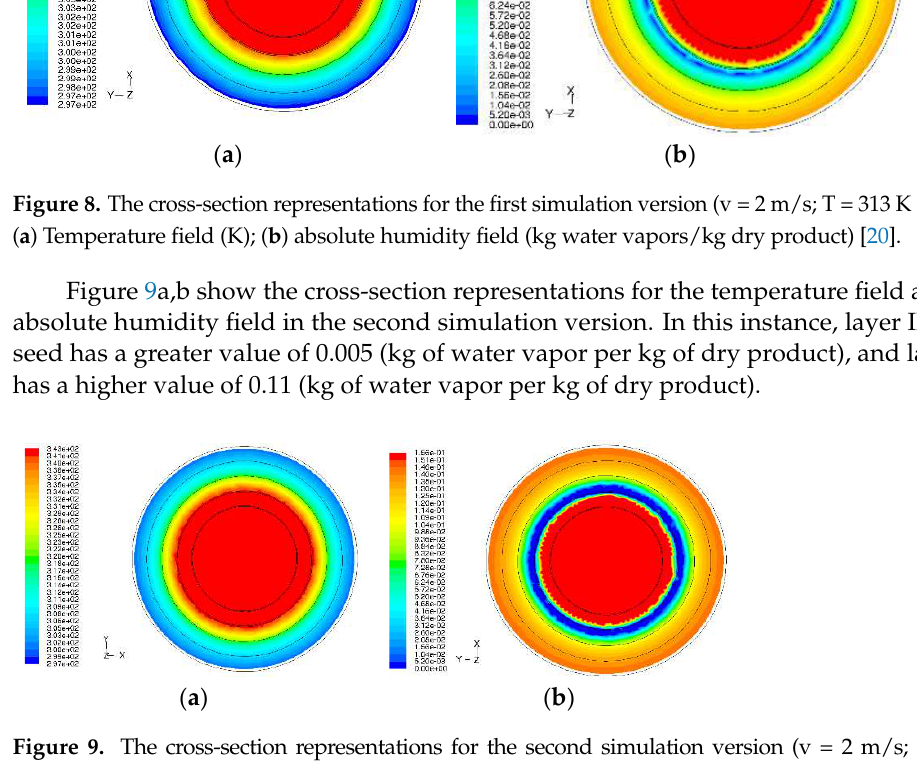
( a ) ( b ) Figure 10. The current line fields inside the cylindrical box with baffles and three layers for the first version (temperature of 313 K = 40 °C): ( a )—velocity (m/s); ( b )—temperature (K) [32]. The same speed rise in the deflector region is seen in the CFD simulation variation II at an air velocity of 2 m/s and its input temperature of 343 K (70 °C), which will uniformly be reached again at 2 m/s on the surface of the first grain seed bed. The line speed lowers to 0.3 m/s at the departure of the final layer after passing through the first three layers of the maize seed. Due to the constant geometry, the distribution of air velocity in the three-